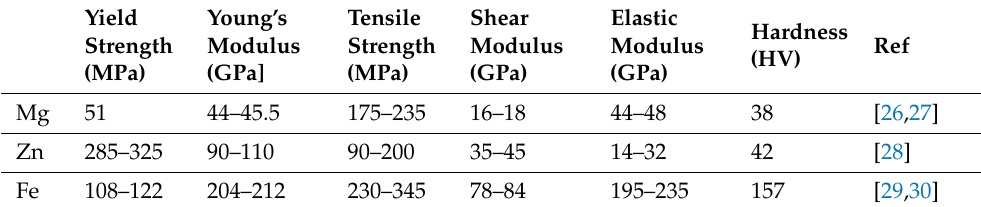
Table 1. The mechanical properties of biodegradable